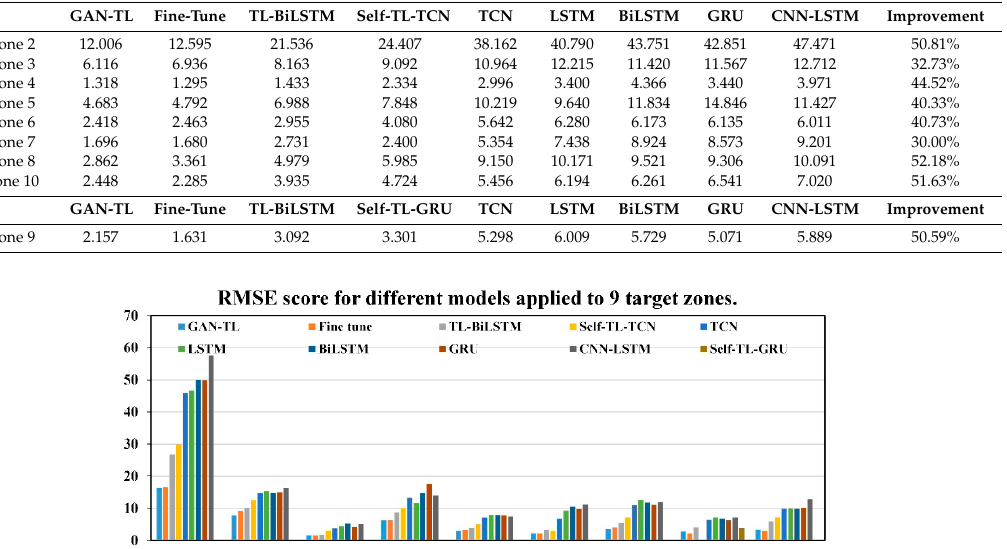
Table 9. MAE scores for di ff erent models applied to nine target zones.